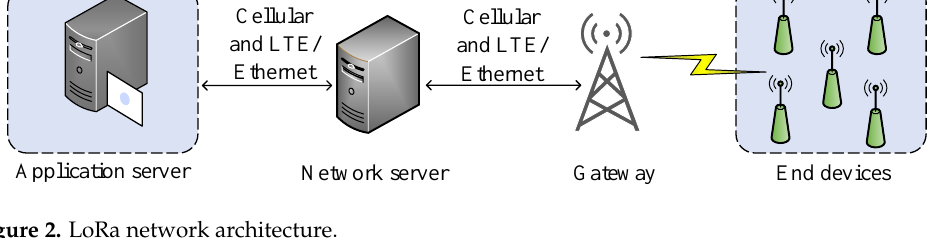
Figure 2. LoRa network architecture.